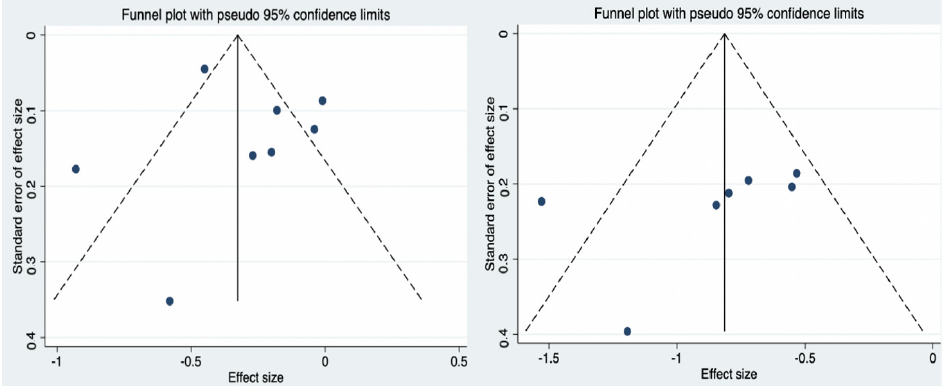
Figure 10. Funnel plot of publication bias for the primary outcomes.